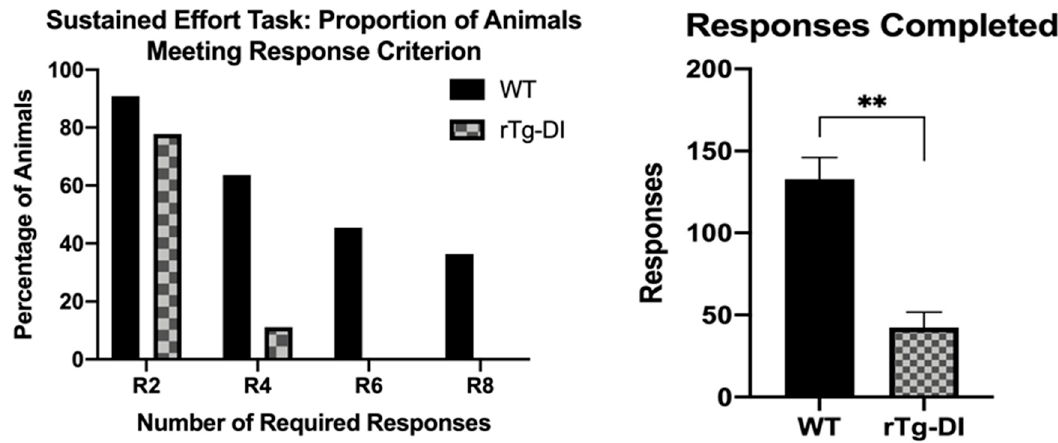
Figure 7. The number of rats to successfully meet response criteria and total responses completed on a sustained effort task (DRH) at 11 months of age. ( A ) rTg-DI met a lower response criterion (two responses within 10 s in the R2 condition, four responses within 10 s in the R4 condition, and so on) than WT rats. ( B ) DRH average responses; rTg-DI made fewer overall responses during the R2 condition than WT rats. ** p < 0.001 . Data represent mean + SEM.